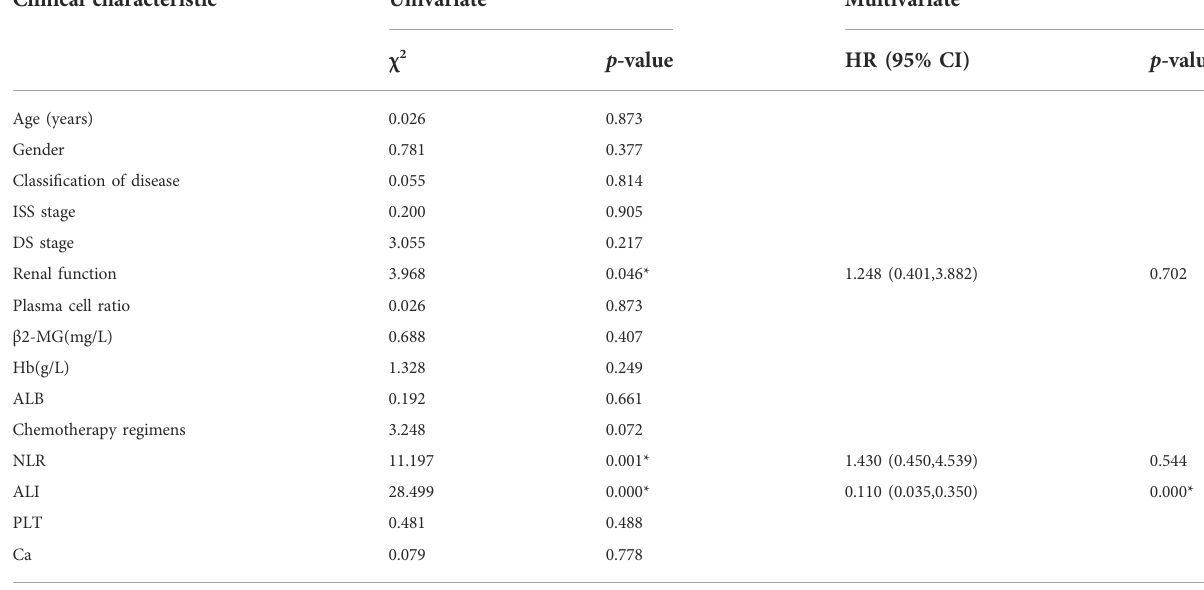
TABLE 3 Univariate analysis and multivariate analysis of the response to chemotherapy.